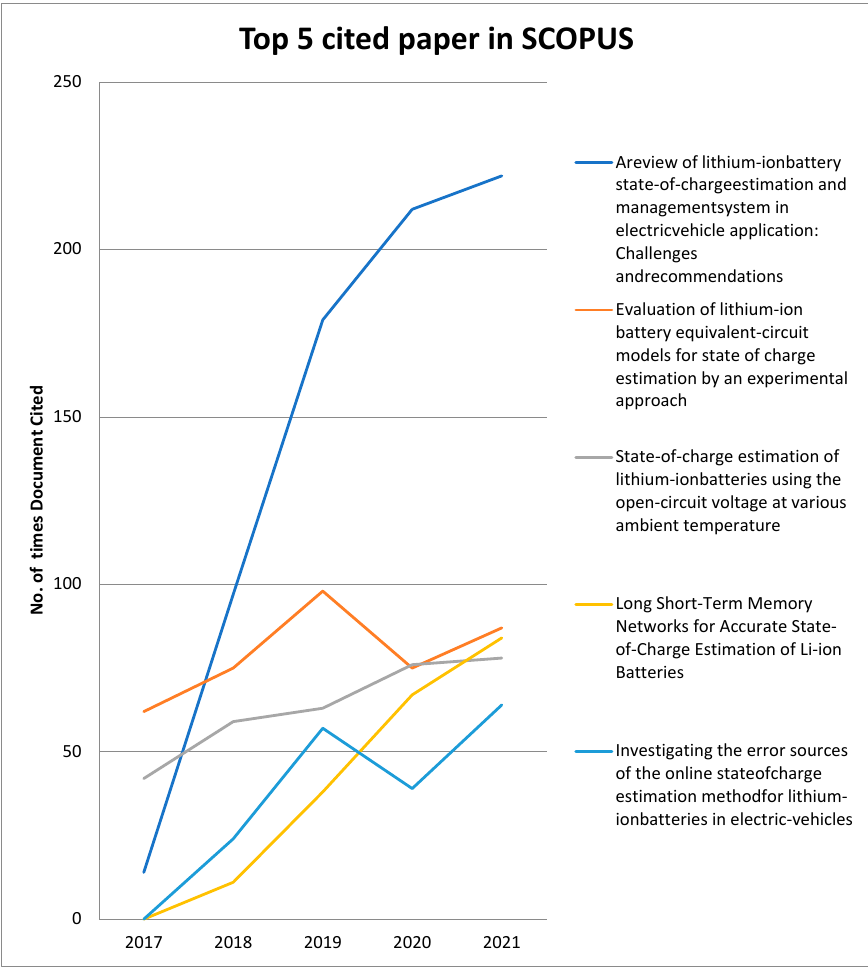
Figure 12. Top five cited papers of BMS EV across 5 years in SCOPUS DB.